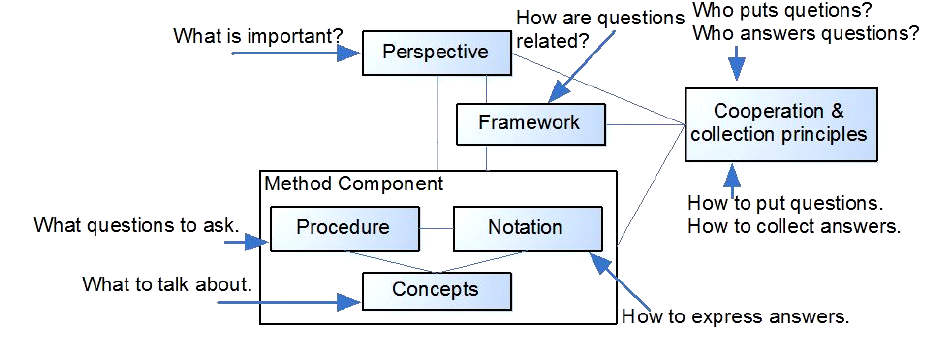
Figure 4. The notion of method